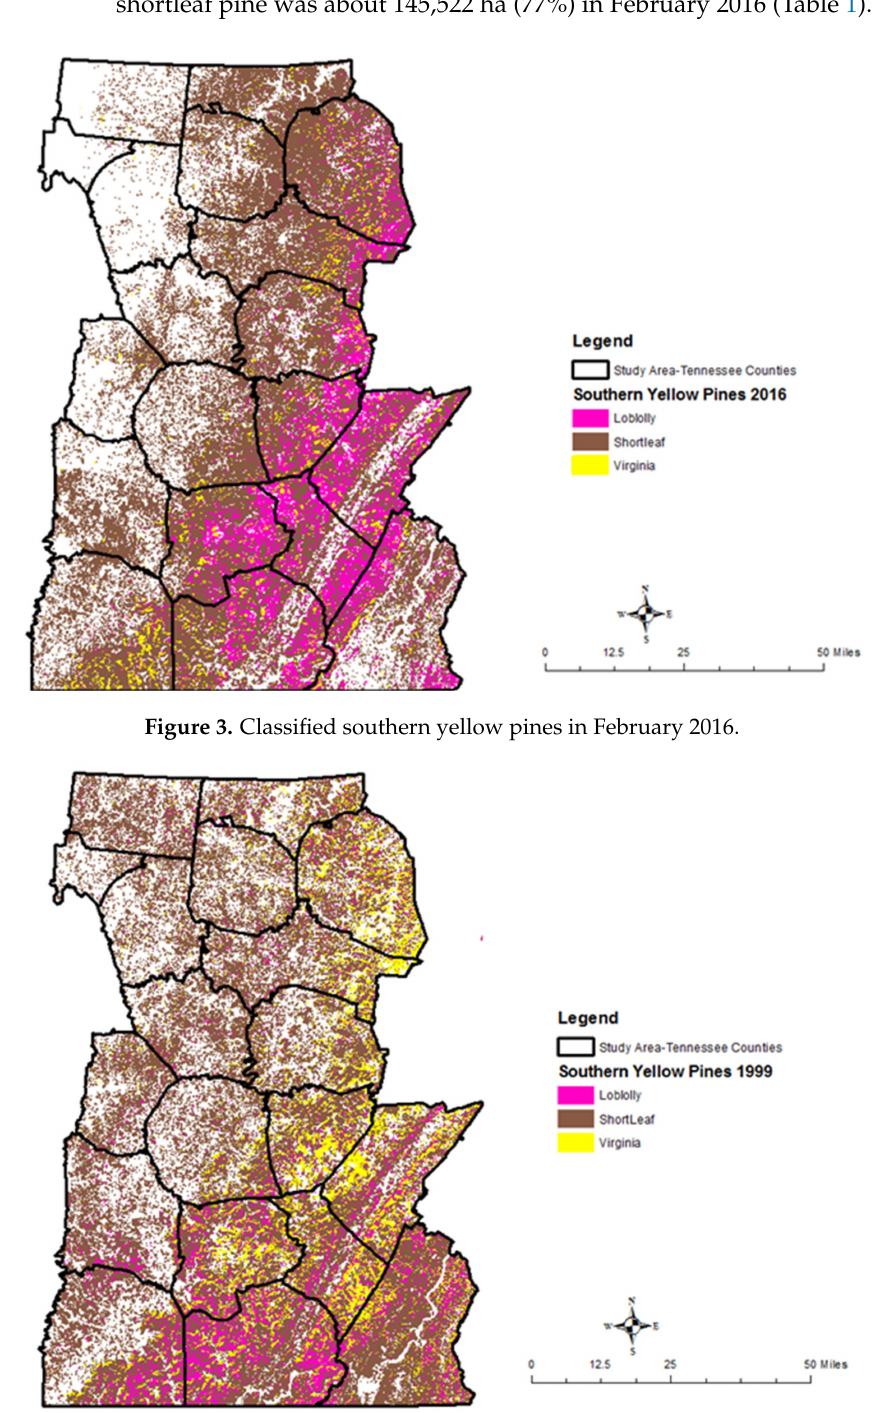
Figure 4. Classified southern yellow pines in November